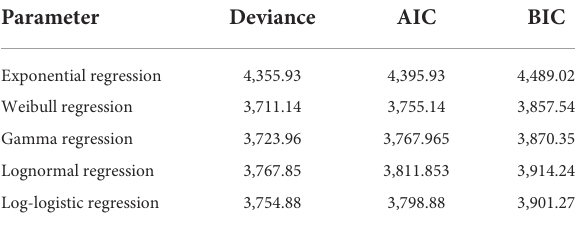
TABLE 4 Model comparison